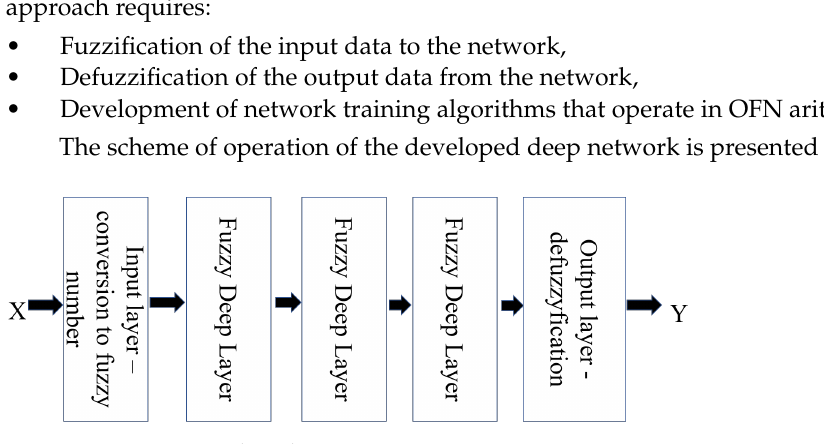
Figure 5. Fuzzy network with OFN.